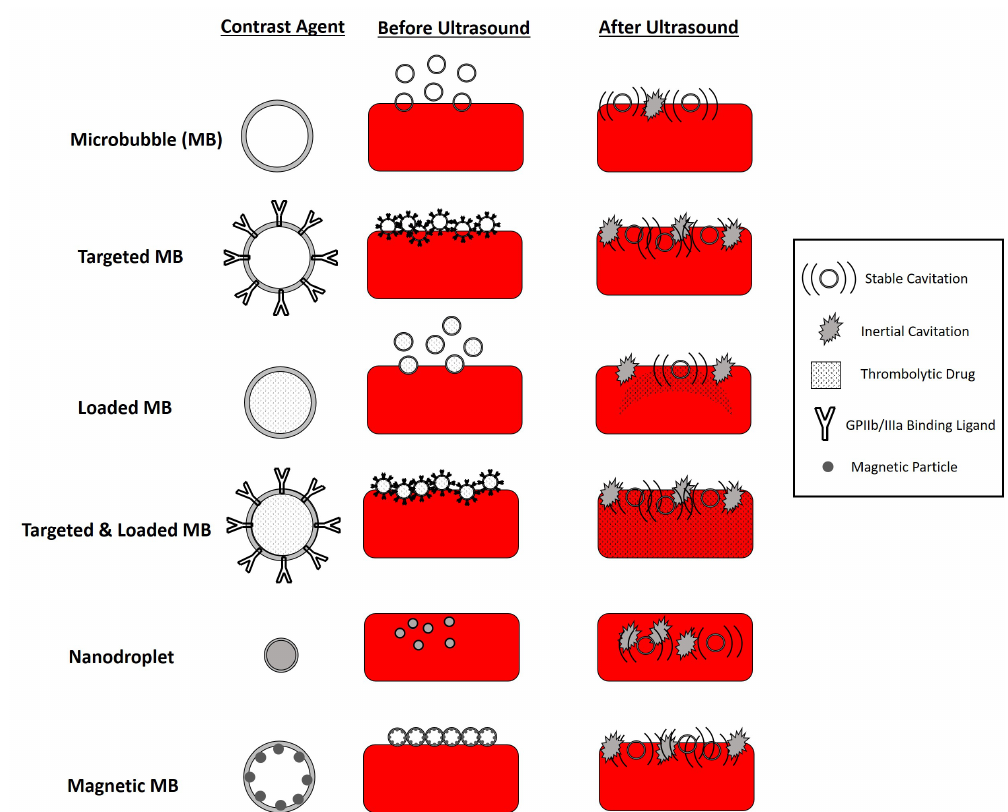
Figure 2. Schematic of Novel Contrast Agents for Sonothrombolysis.